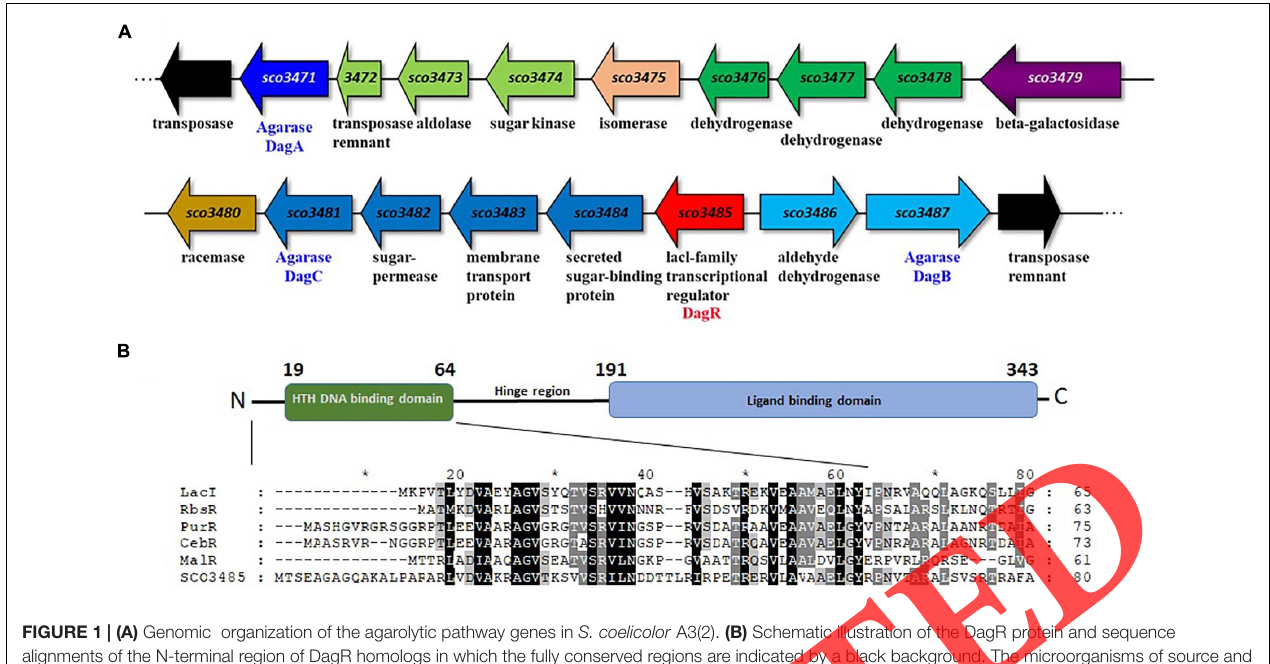
gene ( (cid:49) sco3485/pWHM–3485). While there was no